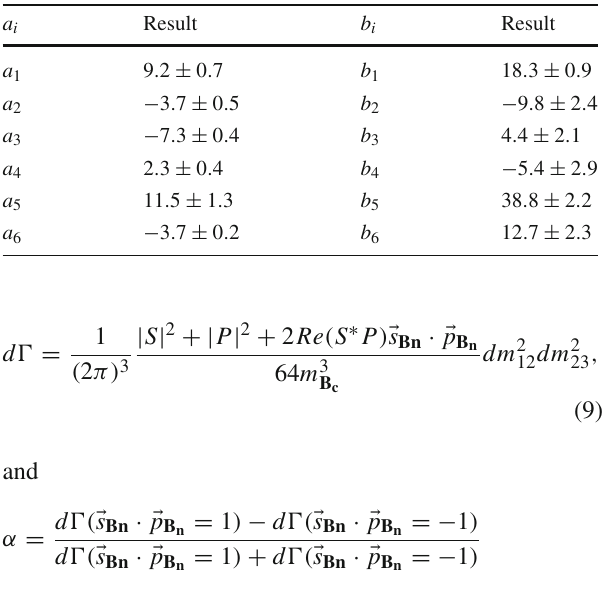
Table 5 Fitting results for a i and b i in unit of GeV 2